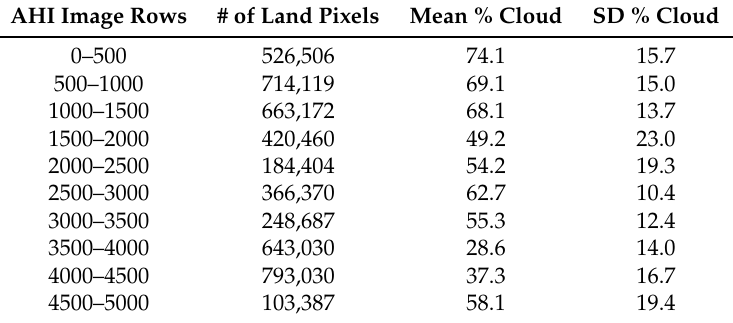
Table 2. Average and standard deviation of cloud coverage for the AHI land areas covered in the study. The figures are an aggregate of 36 images recorded at 0500 UTC as mentioned in Section 2.1, broken into horizontal slices of the AHI disk as shown in Figure 2. AHI Image Rows # of Land Pixels Mean %